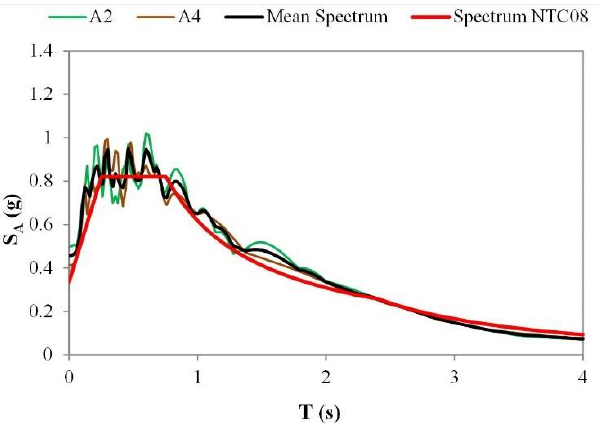
Figure 8. Response spectra related to the two artificial accelerograms (A2 and A4, representative of soil class D) used within the numerical analyses.